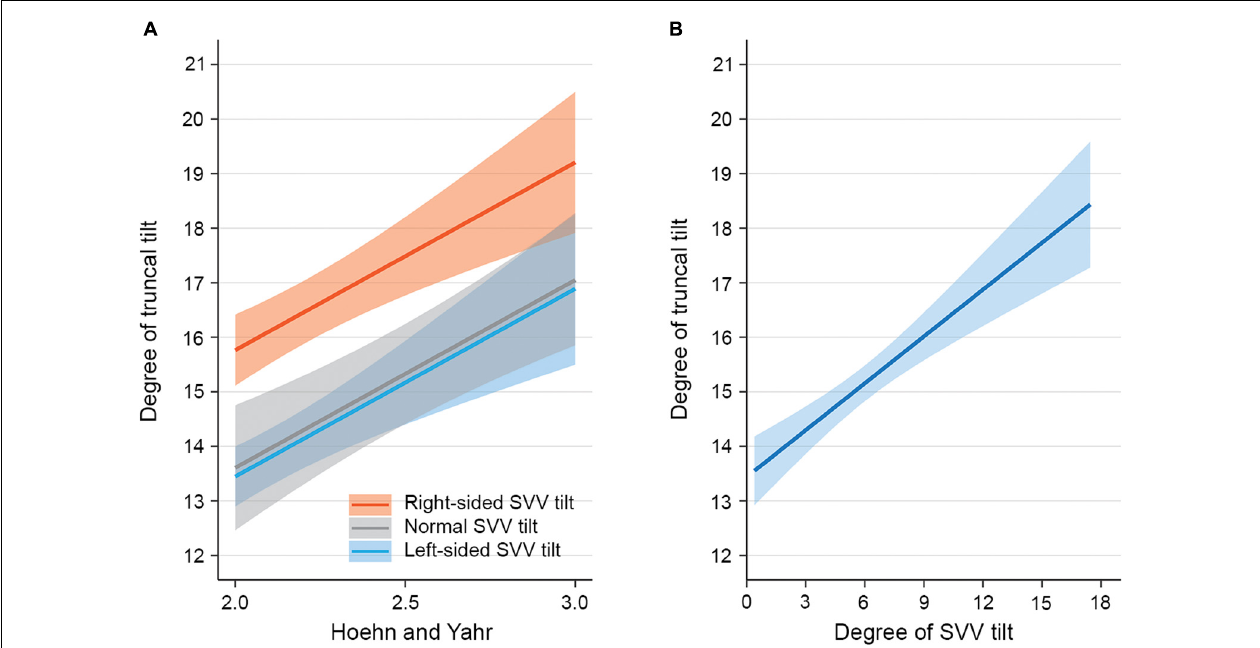
FIGURE 1 | Model-predicted degree of truncal tilt in patients with Parkinson’s disease (PD) and Pisa syndrome (PS). (A) The estimated mean degree of truncal tilt (solid lines) with SEs (shaded area) from a multivariable linear regression model including the direction of subjective visual vertical (SVV) tilt. The estimated mean degree of truncal tilt is illustrated over Hoehn and Yahr stage for each PD-PS patient subgroup with right-sided SVV tilt, normal SVV tilt, and left-sided SVV tilt. The estimates are adjusted for covariates such as age, Berg Balance Scale (BBS), Unified Parkinson Disease Rating Scale motor score (UPDRS-III), asymmetry score of motor symptoms, right-sided dominance of motor symptoms, unilateral canal paresis, and unilateral electromyographic (EMG) hyperactivity of paraspinal muscles. (B) The estimated mean degree of truncal tilt (solid line) with SEs (shaded area) from a multivariable linear regression model including the degree of SVV tilt. The estimated mean degree of truncal tilt is illustrated over the degree of SVV tilt. The estimates are adjusted for covariates such as age, BBS, UPDRS-III, asymmetry score of motor symptoms, right-sided dominance of motor symptoms, unilateral canal paresis, and unilateral EMG hyperactivity of paraspinal